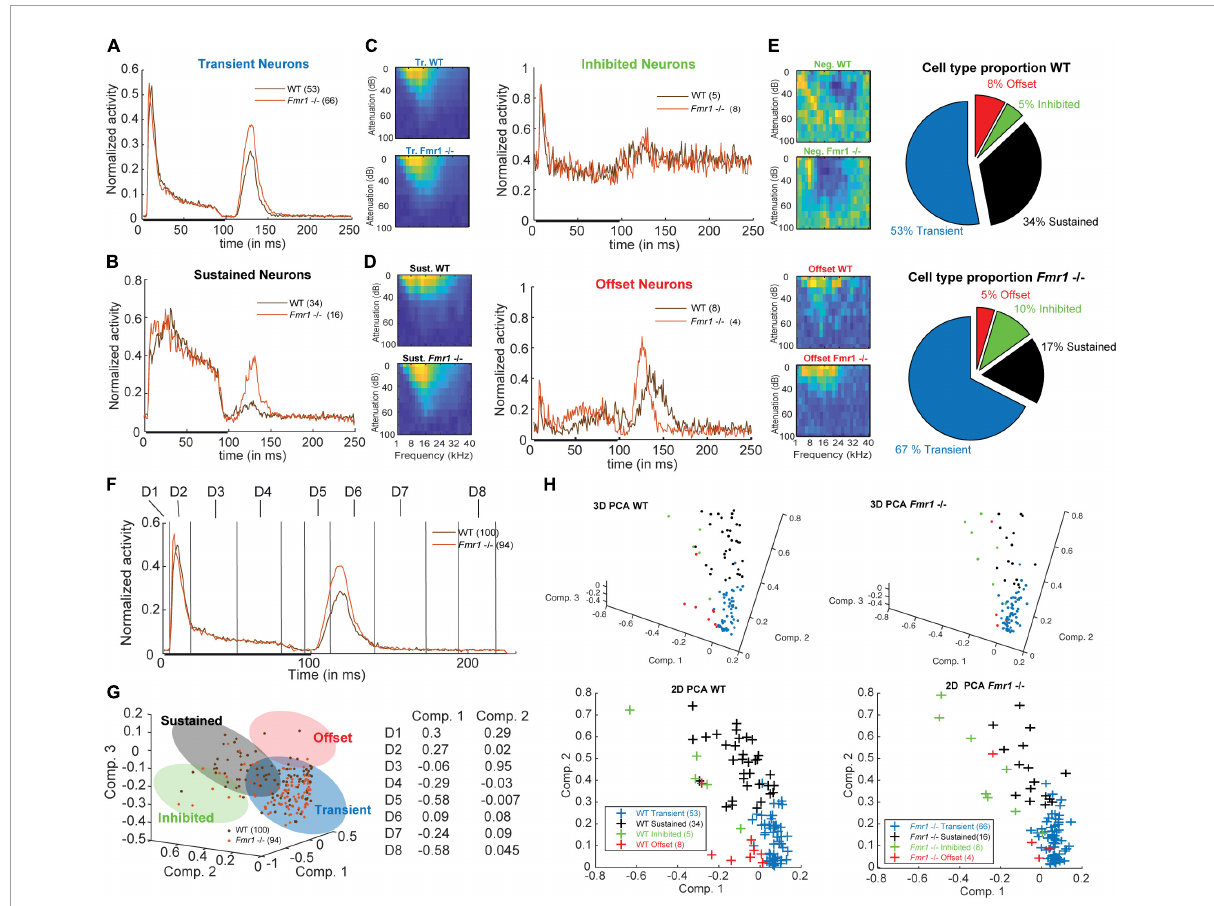
FIGURE2 Four neuronal response patterns in both genotypes. (A) (left) Averaged compound PSTH of all transient neurons, (brown) WT and (orange) Fmr1 -/- ; (right above) Averaged FRA of all WT transient neurons and (right below) FRA of all Fmr1 -/- transient neurons. (B) (left) Averaged PSTH of all sustained neurons WT, and Fmr1 -/- ; (right above) FRA of all WT sustained neurons, and (right below) their Fmr1 -/- counterparts. (C) (left) PSTH of all inhibited neurons, WT and Fmr1 -/- ; (right above) FRA of all WT inhibited neurons, and (right below) their Fmr1 -/- counterparts; note the negative tuning that these neurons’ FRAs exhibit. (D) (left) PSTH of all offset neurons, WT and Fmr1 -/- ; (right above) FRA of all WT all offset neurons, and (right below) their Fmr1 -/- counterparts. (E) Proportion of each cell types in (above) WT and (below) Fmr1 -/- neurons. (F) All-cell average of all compound PSTHs in the WT and Fmr1 -/- mice. Different values of the transient firing are taken in each time-window for each cell (D1-D8), used for the following principal component analysis (PCA). (G) (left) 3D-representation of all recorded neurons along the first three components. Note the four shaded areas corresponding to the four cell types detailed above. (Right) Projections of the two first principal components on the eight time-windows. (H) (above left) 3D-representation of all WT neurons; (below left) same neurons represented along the two first components; (above right) 3D-representation of all the Fmr1 -/- neurons; (below right) 2-D projection of all the Fmr1 -/- neurons on the two first